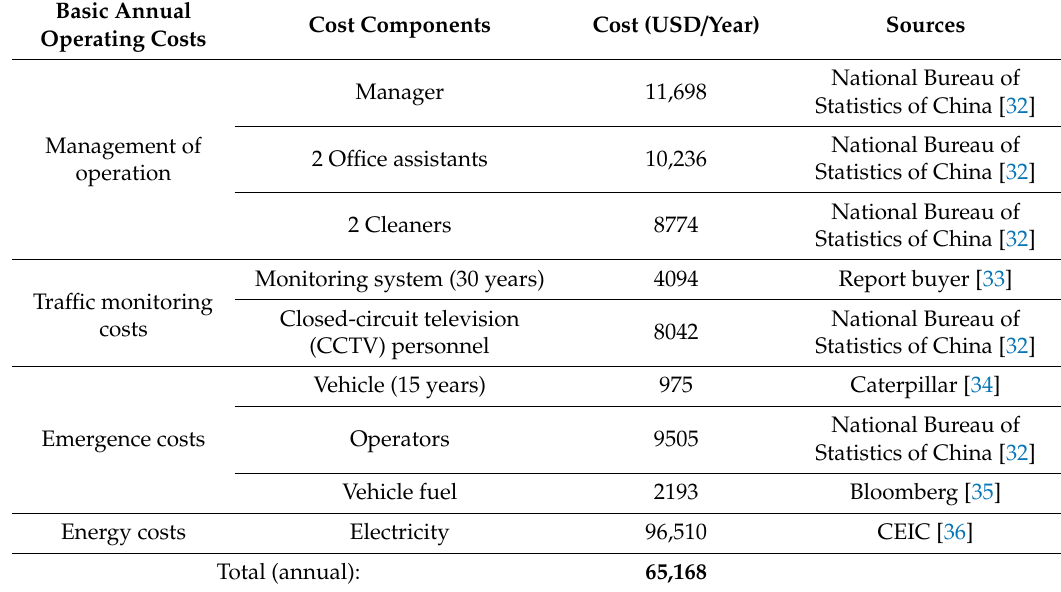
Table 4. Operation costs.